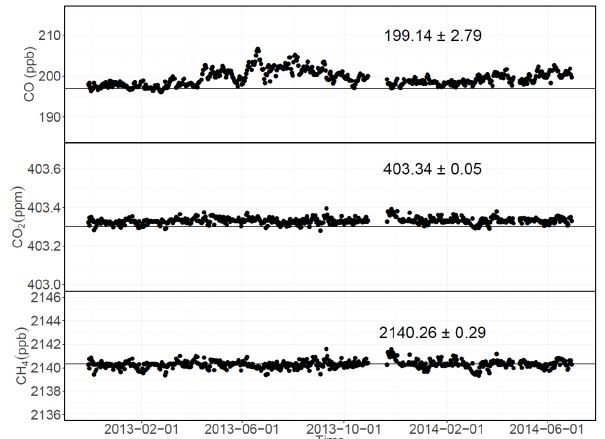
Figure 6. Target gas time series after correction and span calibration following the new two-variable linear regression